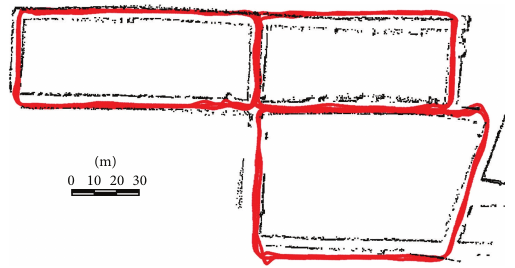
Figure 14: Results of the proposed ranging and SLAM algorithm from a different experiment, with state observer ground truth. All measurements are in meters. The experiment was conducted under fluorescent ambient lightning and sunlight where applicable.